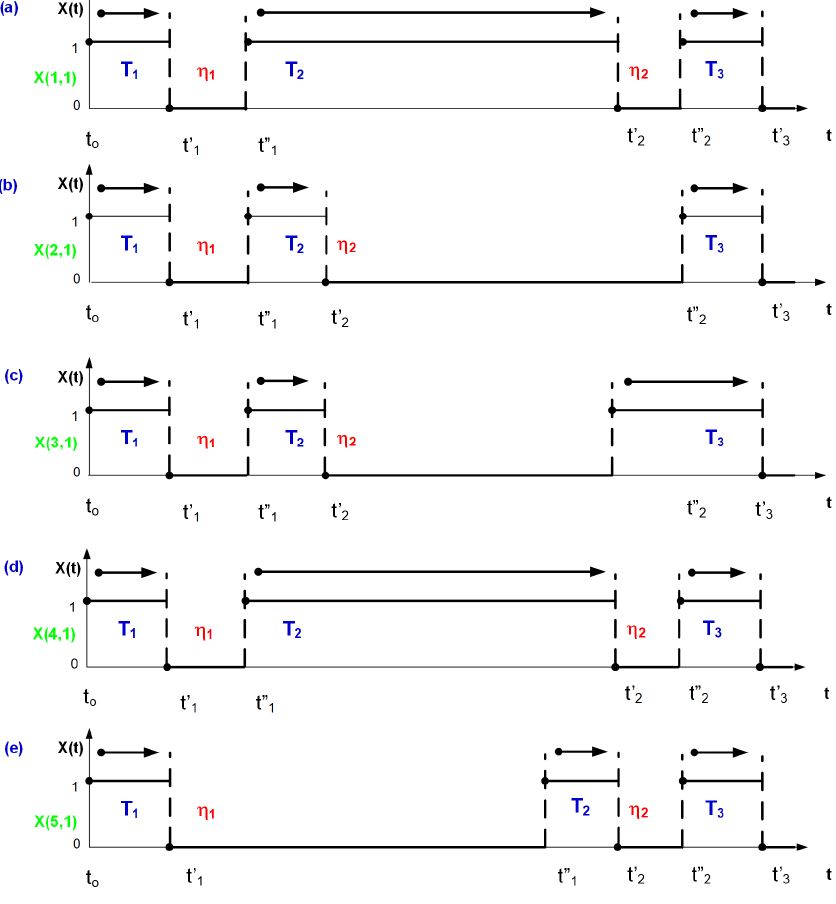
Figure 3. The AIS service availability for a single stream of dynamic data indexed with the MMSI